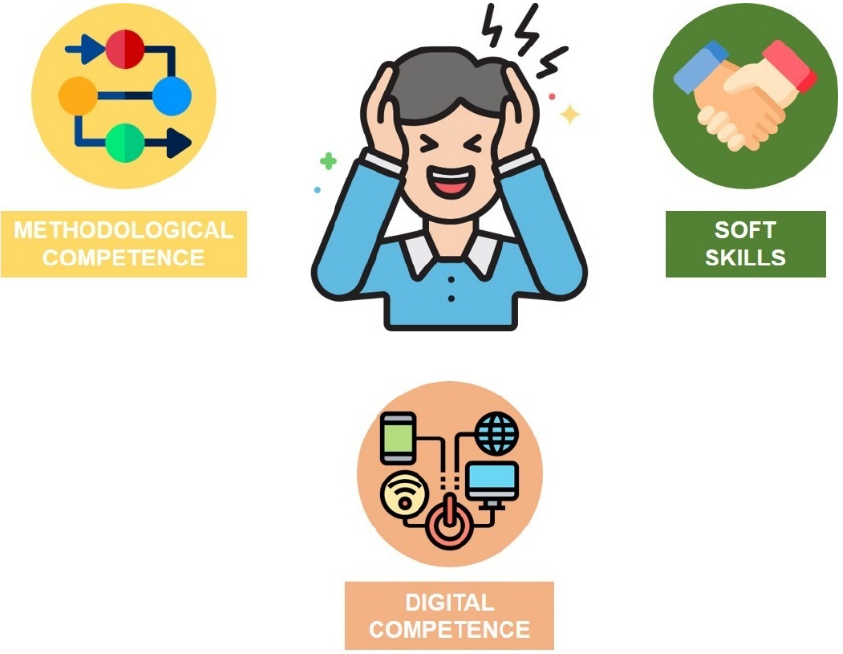
Figure 1. Teacher’s skills and competences to cope with COVID-19 pandemic and the virtualization of education.